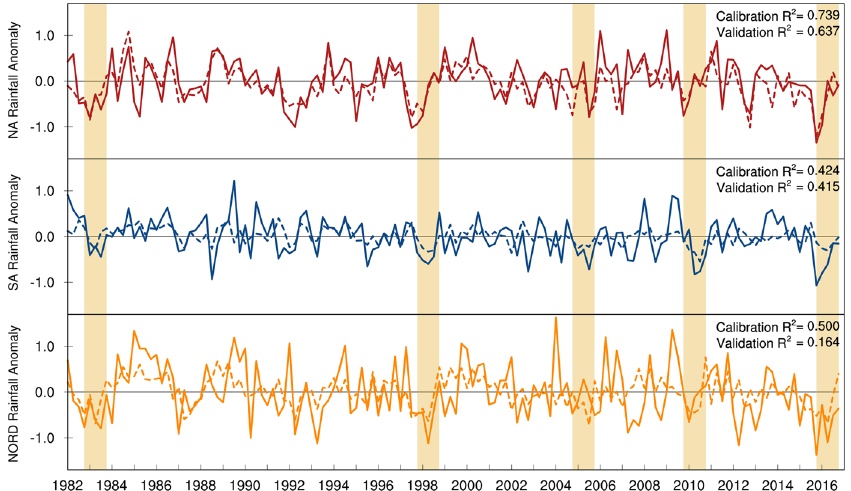
Figure 5. Time series of the predicted (dashed lines) versus observed (solid lines) seasonal precipitation anomalies over North Amazon (top), South Amazon (middle), and Nordeste (bottom). The predicted and observed time series of rainfall deficits are used to calculate coefficient of determination (R 2 ) for